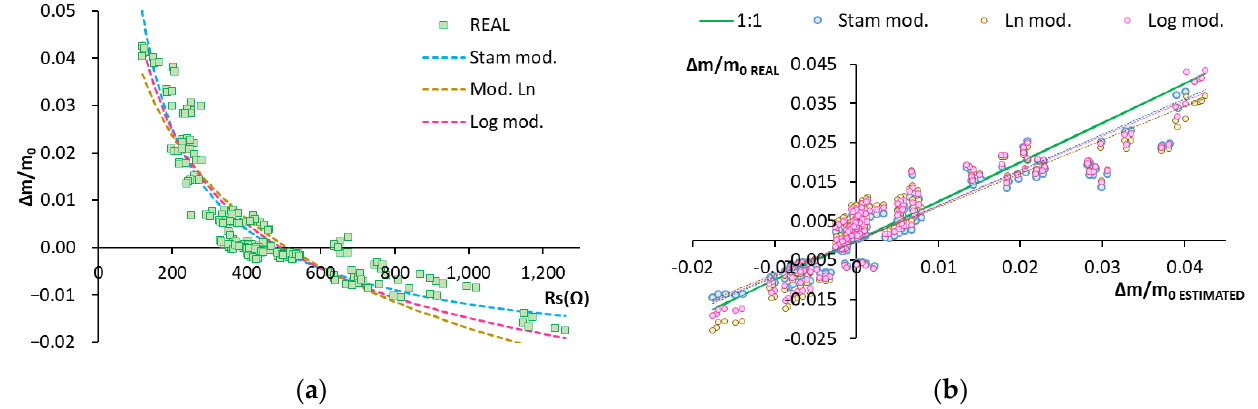
Figure 5. Model of humidity variation according to Rs. ( a ) Graphical representation of the real data vs. those obtained with models. Real data: green squares. Stam model: dashed blue line. Natural logarithm model: dashed yellow line. Common logarithm model: dashed pink line; ( b ) Graphical representation of real data vs. estimated ones. Stam model: blue dots. Natural logarithm model: yellow dots. Common logarithm model: pink dots. Table 3. Statistical parameters for evaluating the goodness of the model used in the fit of Δm/m 0 = f(Rs). Line Slope RMSE R 2 Real vs. Estimated Stam mod. 0.0046